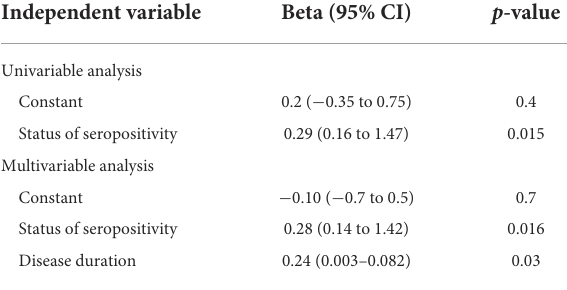
TABLE 5 Results of linear regression analyses of seropositivity status in relation to the joint damage (bone